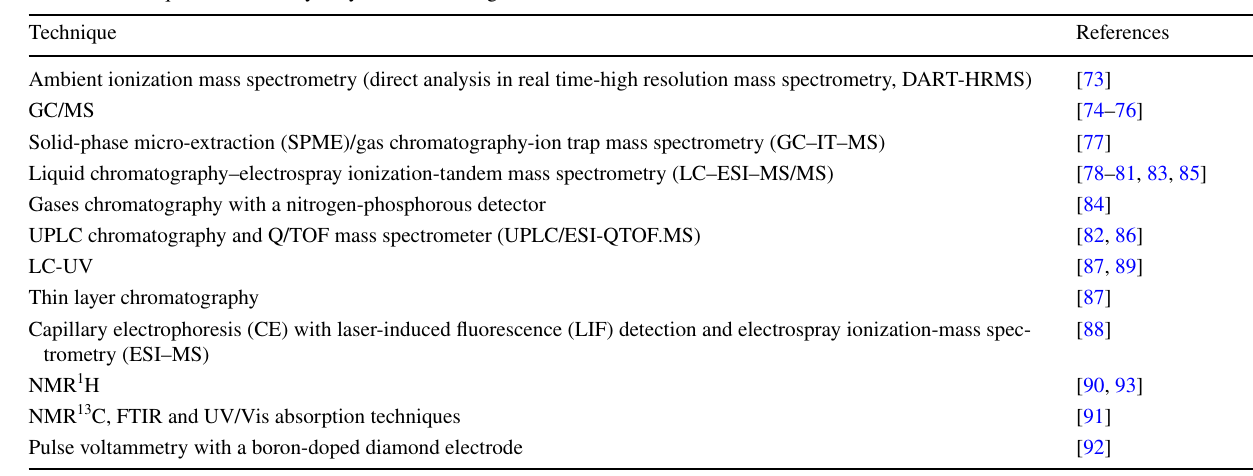
Table 1 Techniques used to analyze ayahuasca beverage